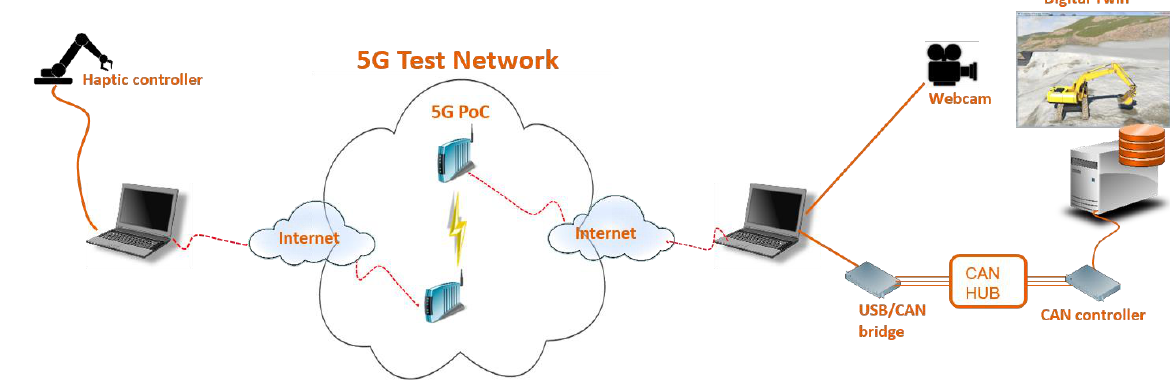
Figure 7: System architecture for the haptic remote control of a virtual machine with a hardware-in-the-loop controller.